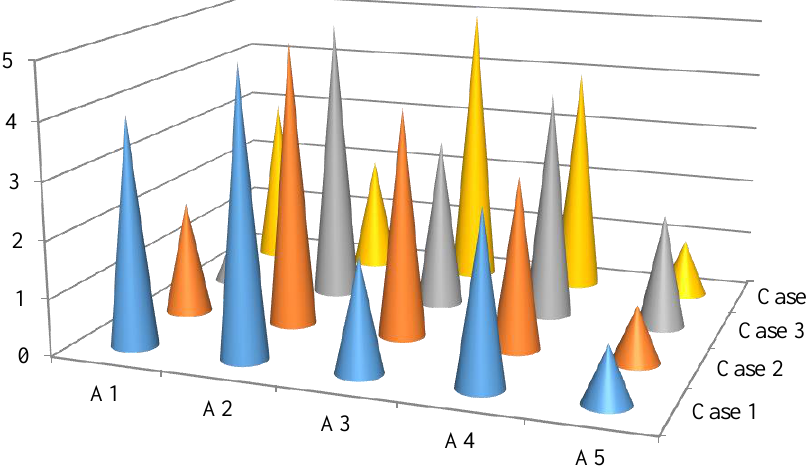
Figure 2. Comparison results of the ranking orders of alternatives based on different reference points.